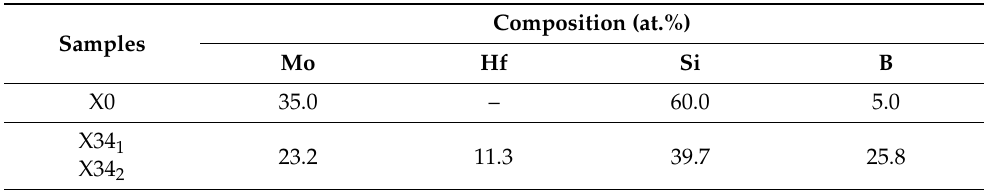
Table 2. The elemental composition of various samples. Reproduced with permission [96]. Copyright 2019 Elsevier.